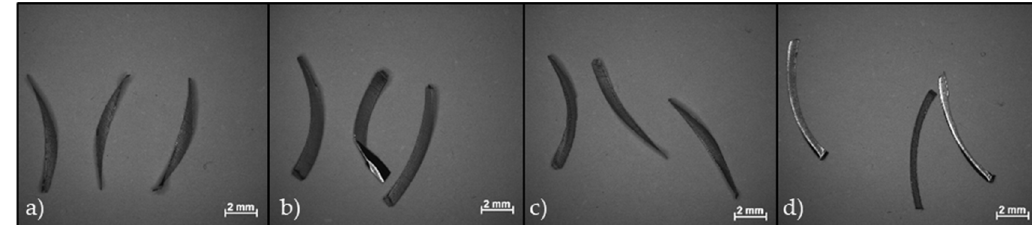
Figure 15. Chips of the milling process of ( a ) SLM, ( b ) WAAM, ( c ) 3DPMD, ( d ) sheet metal.